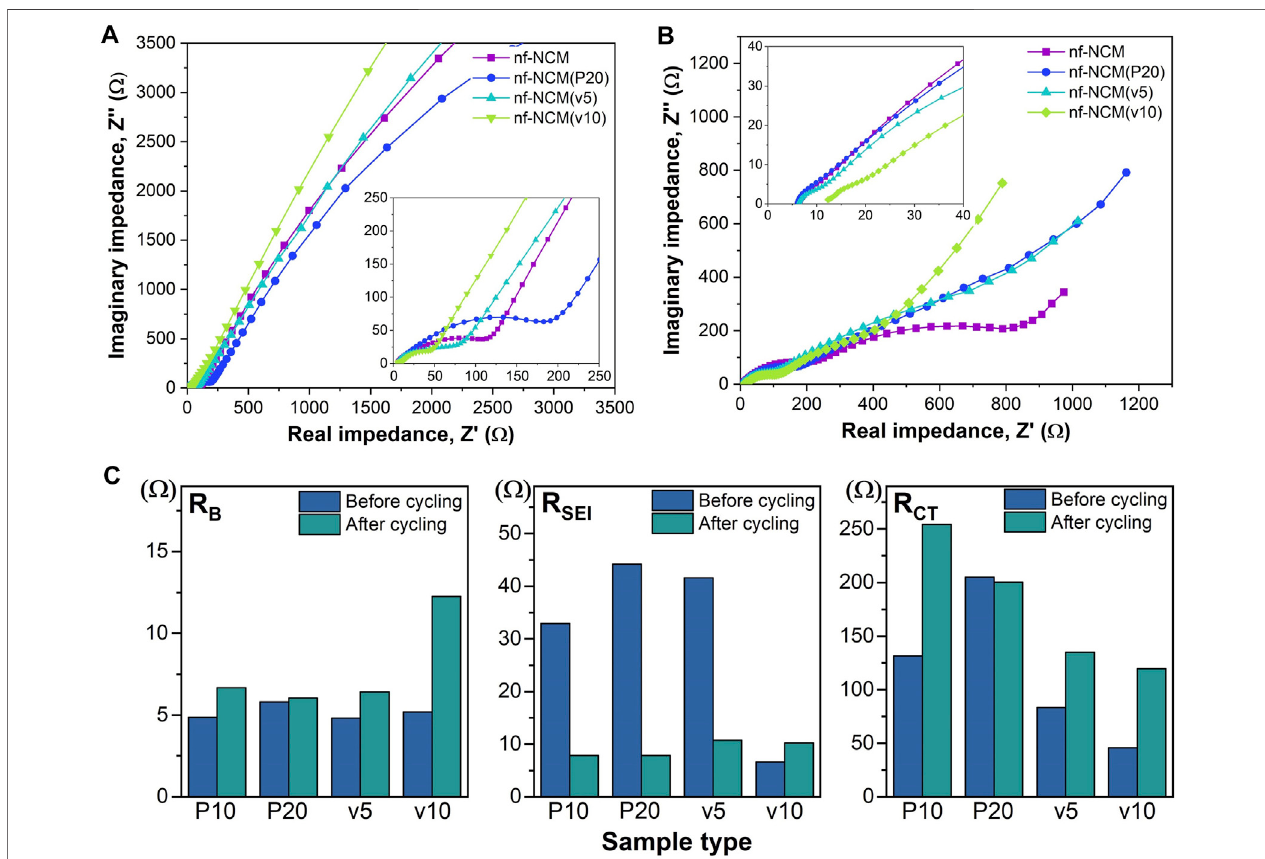
FIGURE4| Electrochemicalimpedancespectrafor (A) beforecyclingand (B) aftercycling. (C) BarchartcomparingtheR B ,R SEI ,andR CT ofallsamplesbeforeand after cycling.